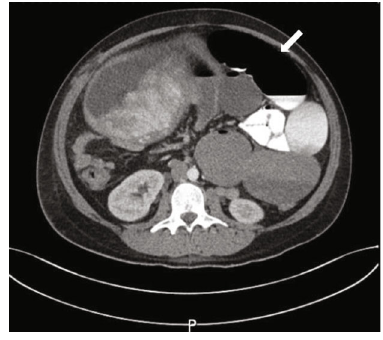
Figure 2: Small bowel obstruction demonstrated on CT. Severely dilated proximal small bowel (arrow) measuring up to 6cm in diameter with abrupt tapering of the small bowel in the mid abdomen posterior to the dome of the